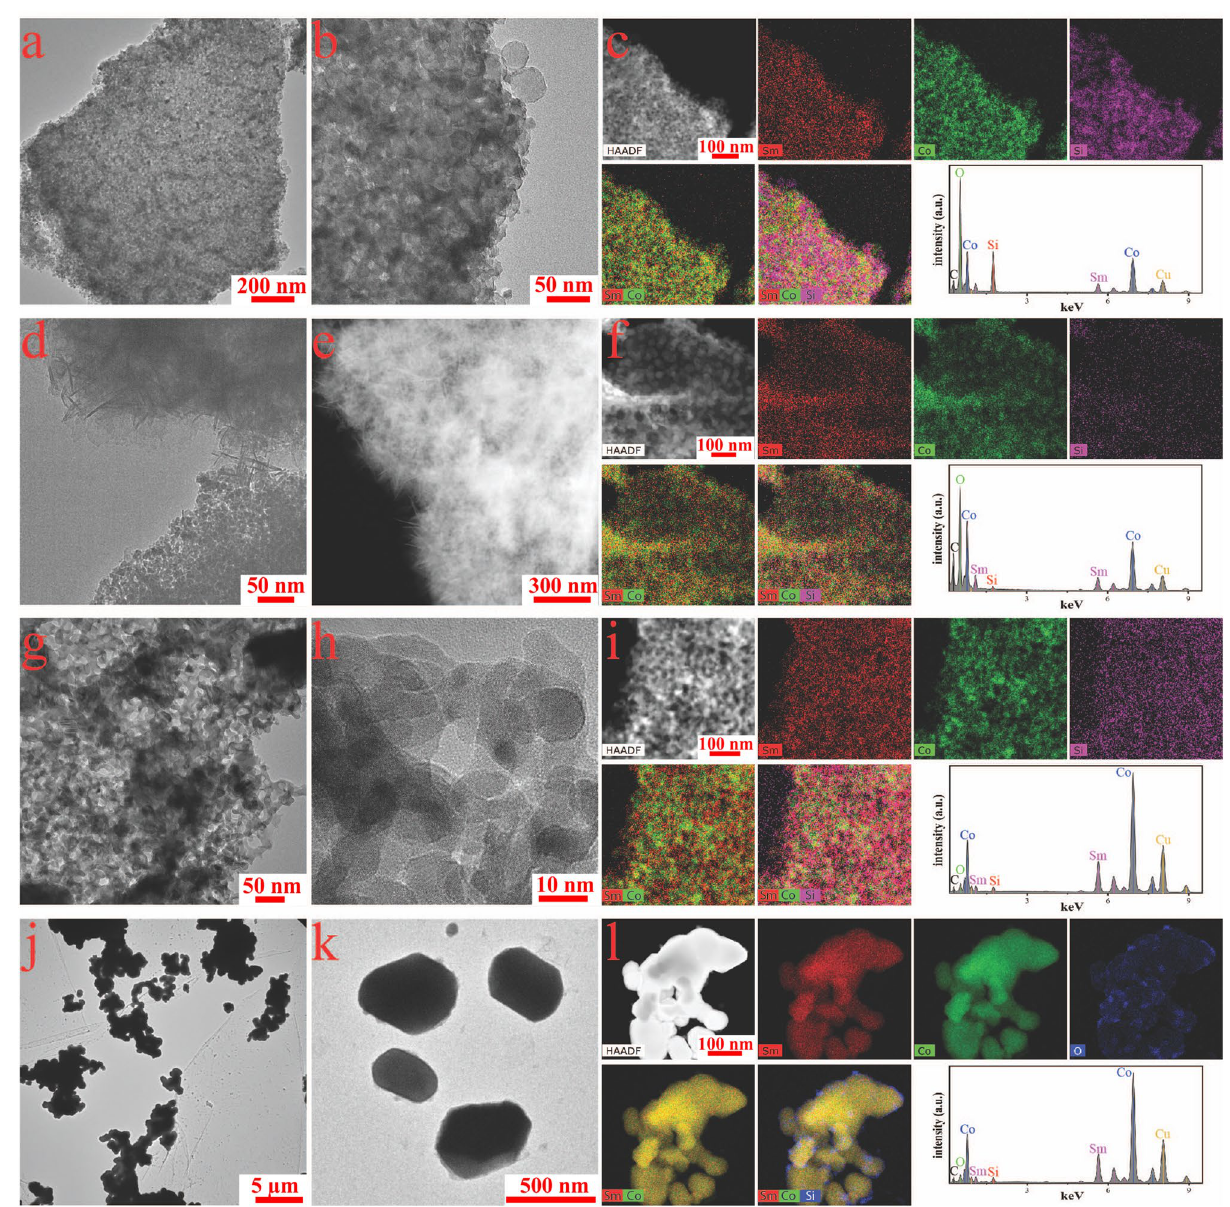
Figure 3. TEM characterization of the CSS_2 sample: ( a ) TEM of the precursor, ( b ) the corresponding high- magnification TEM image, and ( c ) the elemental mapping including EDX the spectrum. ( d ) TEM image of the washed precursor, ( e ) STEM image, and ( f ) the elemental mapping including the EDX spectrum. ( g ) TEM of the H 2 -precursor, ( h ) HR-TEM image, and ( i ) the elemental mapping including the EDX spectrum. ( j ) TEM of the final produced SmCo 5 particles, ( k ) TEM image with high magnification, and ( l ) elemental mapping including EDX spectrum. Software: CorelDraw X6, www.corel